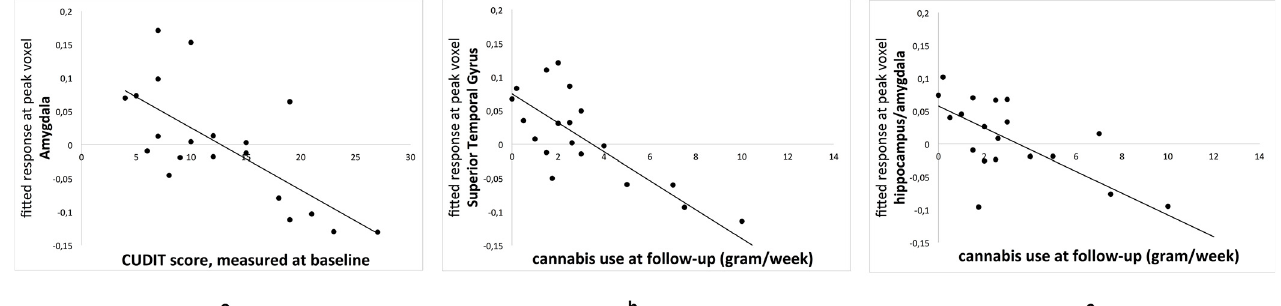
Fig 1. Correlation between the GM density at the peak voxel per ROI and the independent variable. Fig 1a: correlation between CUDIT score at baseline and GM density in the amygdala. Fig 1b: correlation between average weekly cannabis use (gram) at follow-up and GM density in the Superior Temporal Gyrus. Fig 1c: correlation between average weekly cannabis use (gram) at follow-up and GM density in the Medial Temporal Lobe (hippocampus/amygdala).